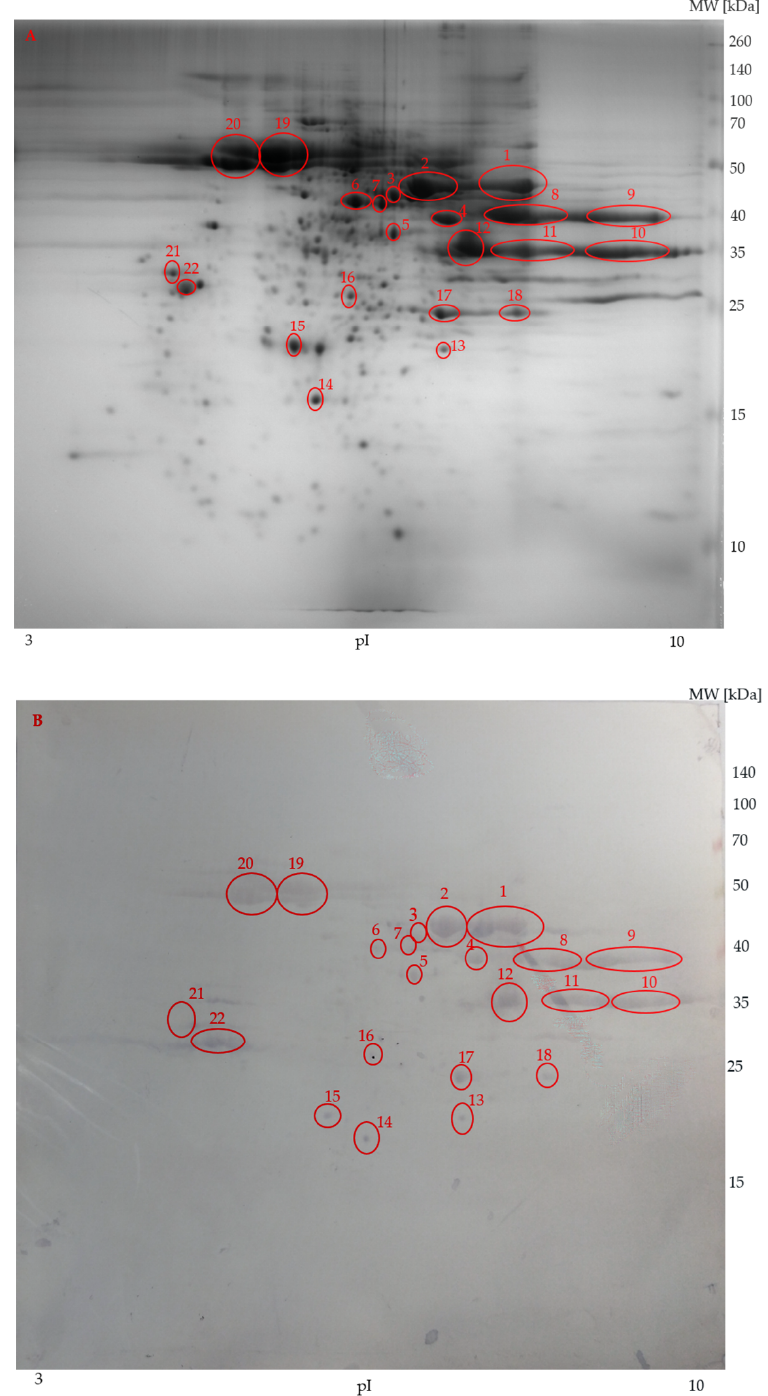
Figure 5. Representative spermatozoa protein profiles ( A ) of sterlet by two-dimensional gel electrophoresis. Western blot reaction of sterlet spermatozoa ( B ). Circles show the reacted protein spots subjected to MALDI-TOF / TOF MS. Molecular weight marker is on the right. pI = Isoelectric